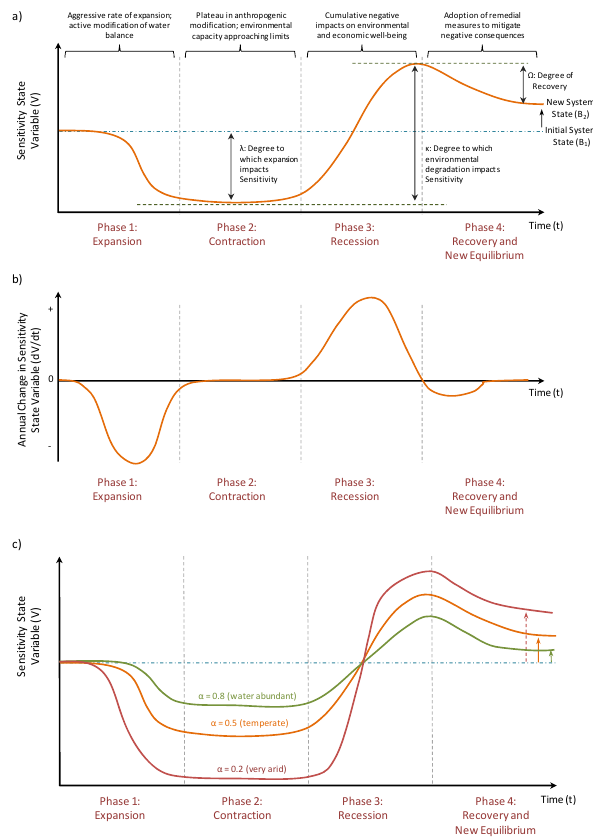
Figure 2. An idealised sketch showing a hypothetical trajectory over time for the (a) Sensitivity state variable, and (b) the change in (cid:16) d V (cid:17) Sensitivity in the case of an example catchment. A compar- d t ison of the idealised trajectory across a regional climate gradient is shown in (c)